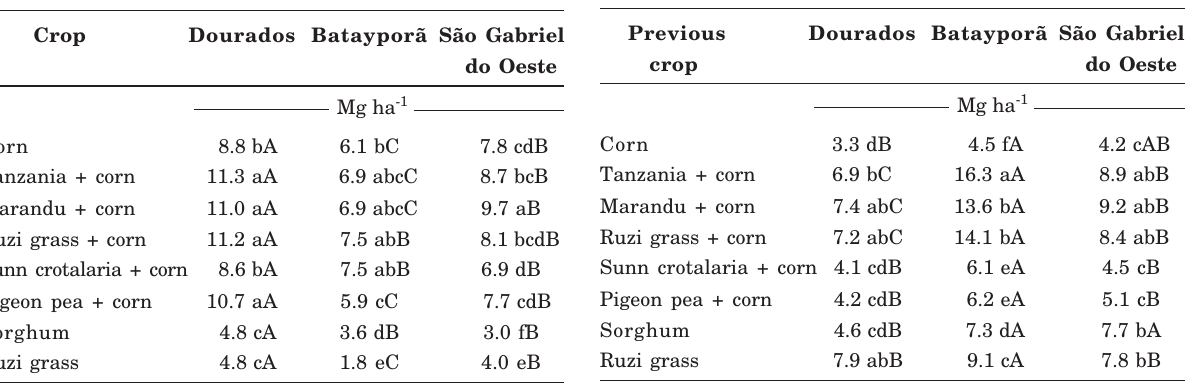
Table 2. Total dry matter yield of late-season corn and forage species when sole or intercropped in July 2005 in Mato Grosso do Sul, Brazil